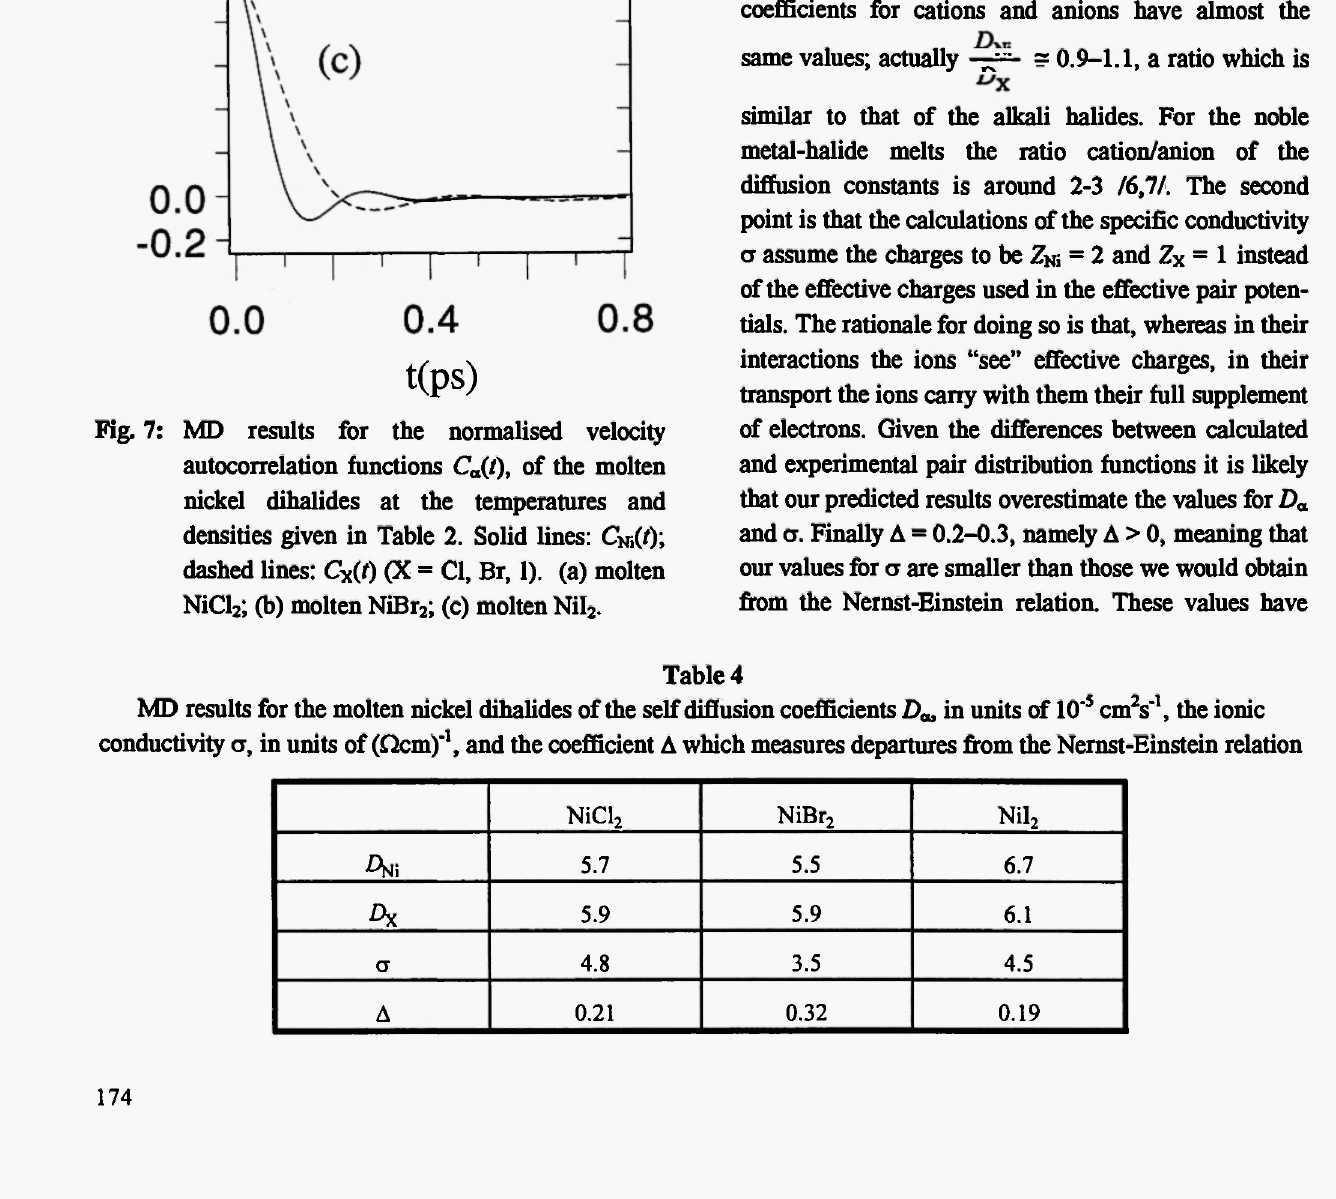
Fig. 7: MD results for the normalised velocity autocorrelation functions C (/), of the molten a nickel dihalides at the temperatures and densities given in Table 2. Solid lines: C (t); Ni dashed lines: Cx(t) (X = CI, Br, I), (a) molten NiCl ; (b) molten NiBr ; (c) molten Nil . 2 2 2